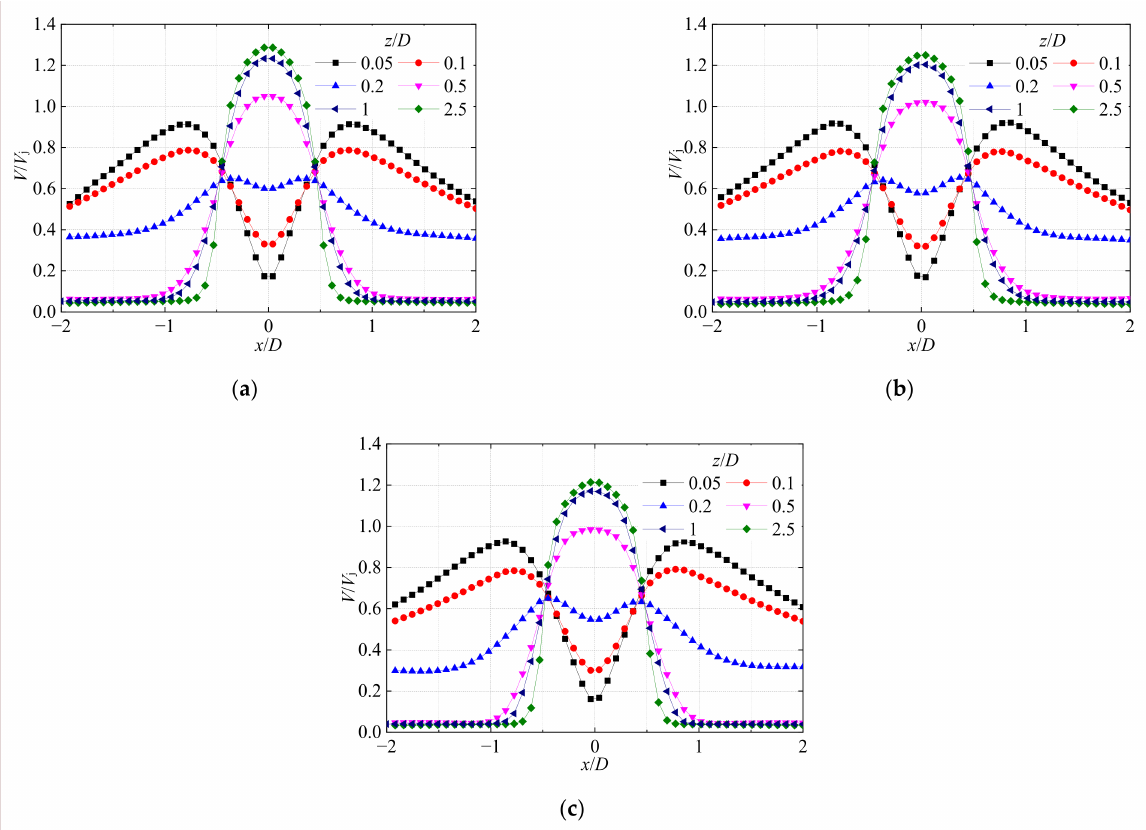
Figure 9. The radial distribution of the dimensionless velocity V/V j at different axial positions in the cross-section of the jet: ( a ) Re = 11,700; ( b ) Re = 23,400; ( c ) Re = 35,100.